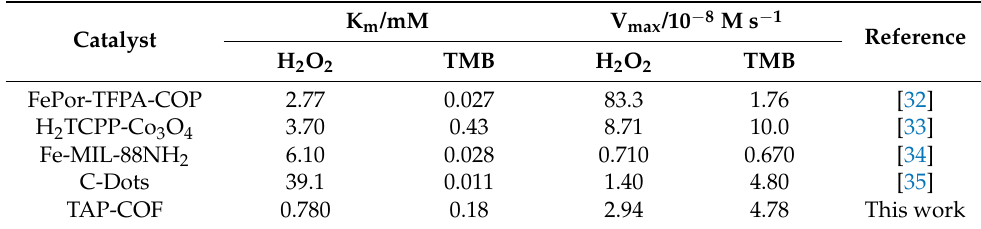
Table 1. Comparison of maximal reaction rate (V max ) and apparent Michaelis-Menten constant (K m ). Catalyst